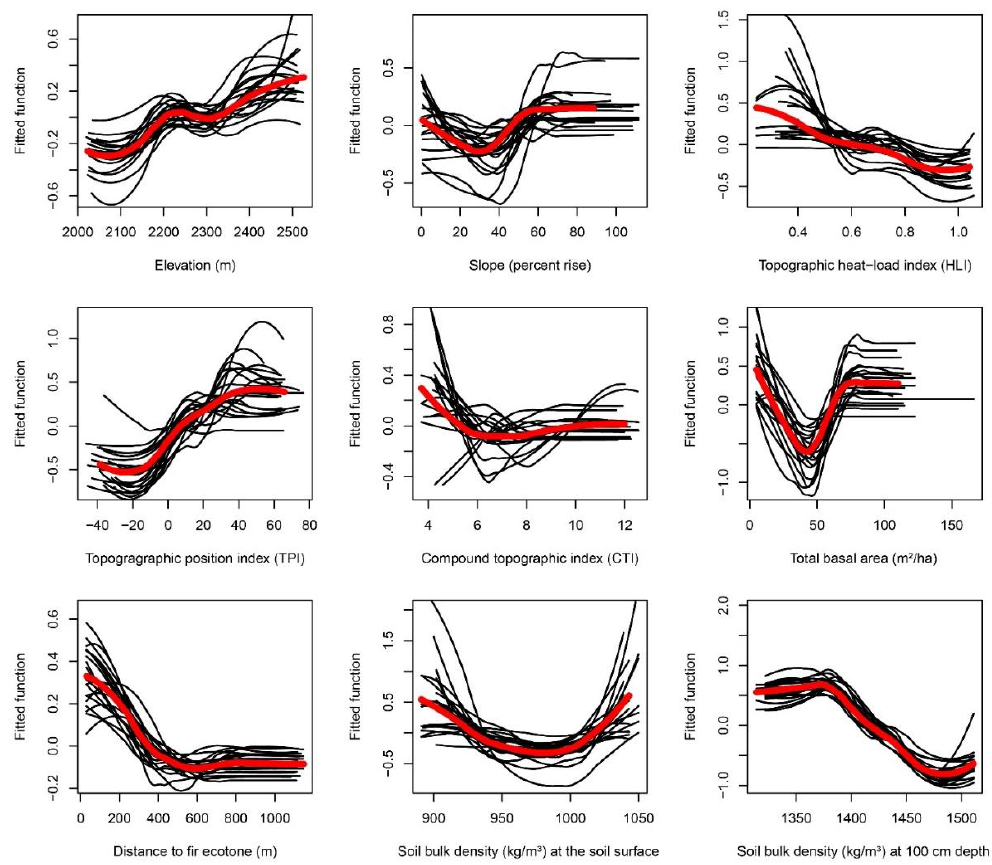
Figure A4. Partial-dependence plots from boosted regression tree models of drought refugia in lodgepole pine areas in 2001. Black lines represent loess-smoothed partial-dependence relationships from 20 independent bootstrapped model runs using a random subsample of n = 2000 grid cells for each model run. Red lines indicate means across 20 bootstrapped model runs. In all plots, higher values on the vertical axis represent greater prevalence of refugia.